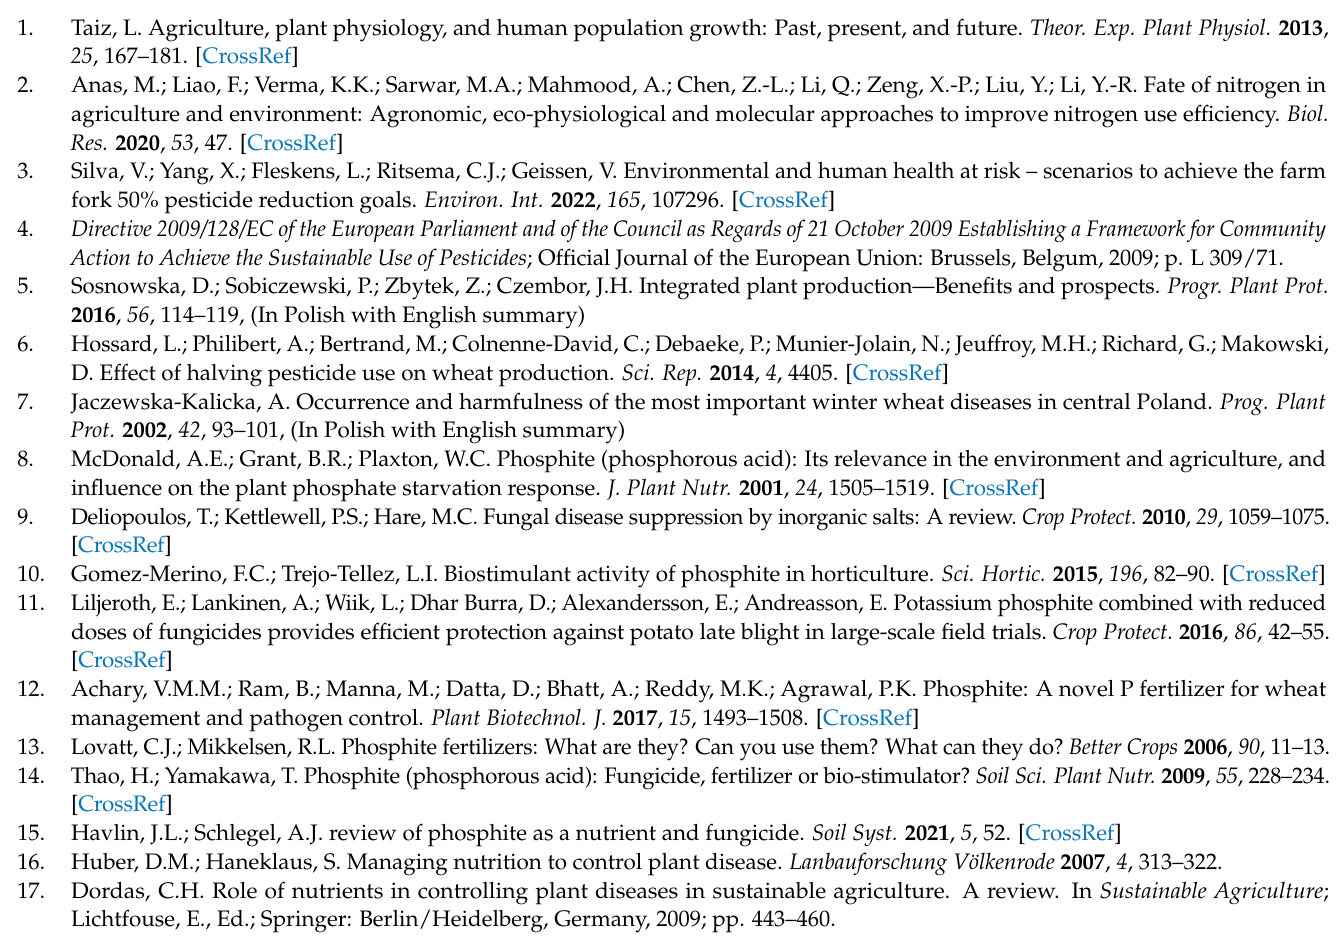
Figure A4. Effect of plant protection methods on the nitrogen unit accumulation index (NUA) of winter wheat at BBCH 75. Similar letters indicate a lack of significant differences using Tukey’s test. The vertical bar in the column refers to the standard error of the mean.